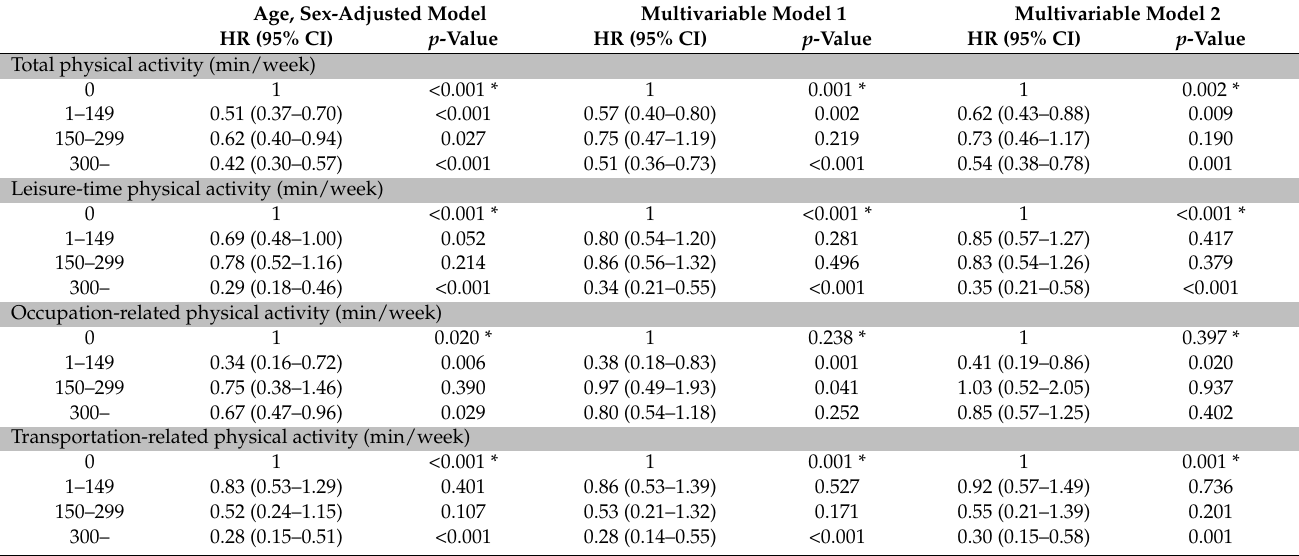
Table 5. Multivariable Hazard Ratio for Cardiovascular Mortality based on the Amount of Physical Activity among Individuals with NAFLD as defined by the Hepatic Steatosis Index.